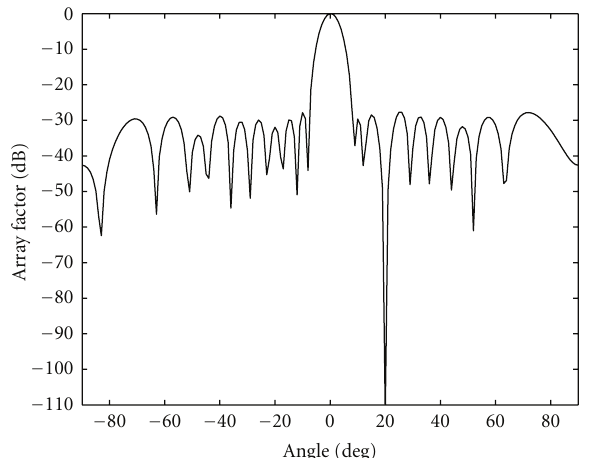
Figure 2: Radiation pattern of 20 element linear broadside array with null at 20 ◦ and SLL of − 30